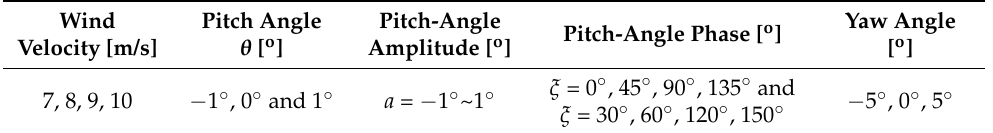
Table 1. Input data of the